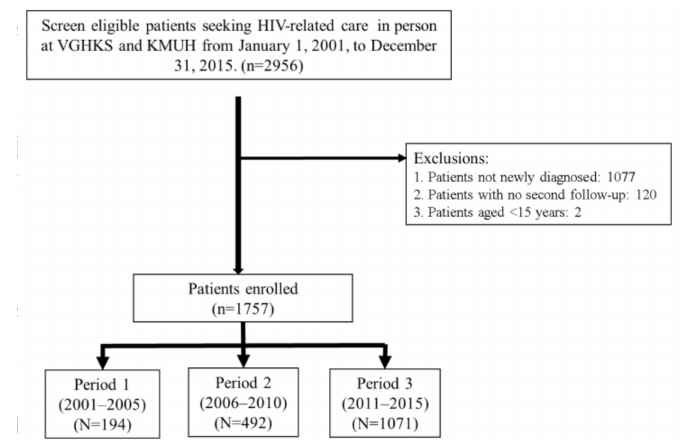
Figure 1. Schematic of the study